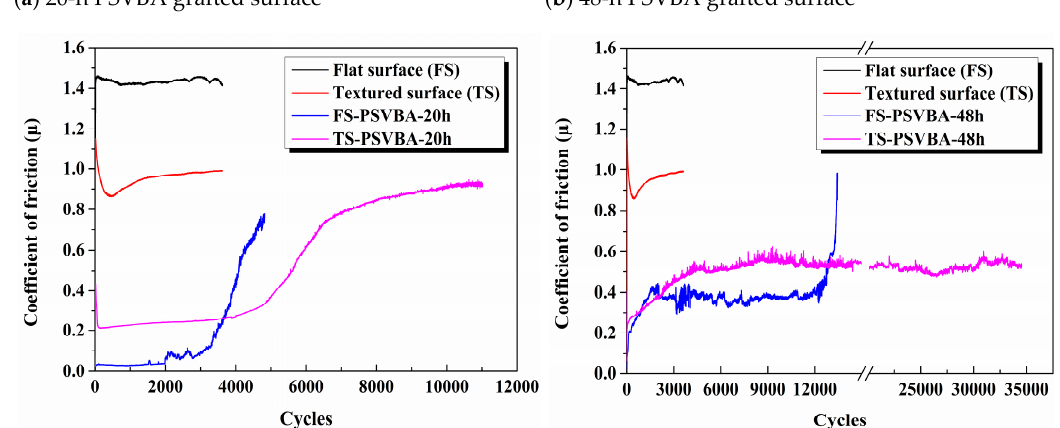
Figure 9. Time-varying curve of friction coefficients of the original and modified surface with different grafting time.